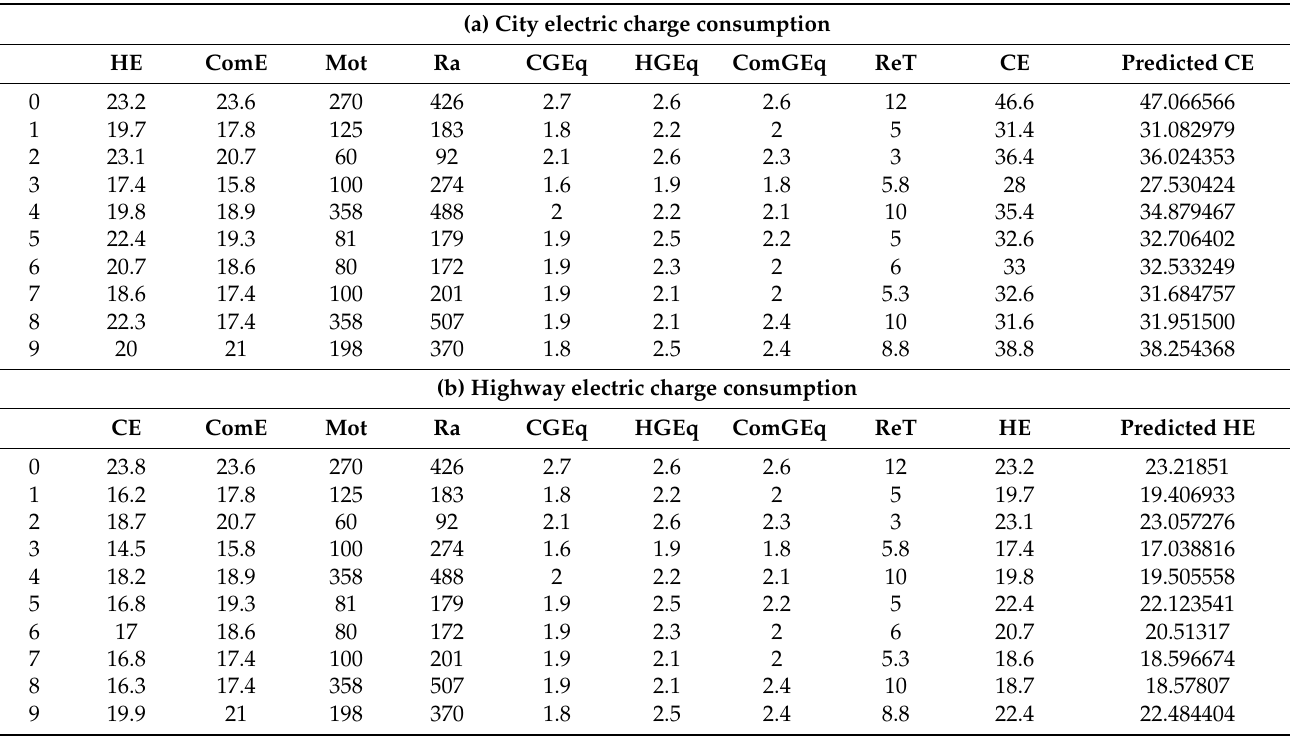
Table 11. Redefined parametric